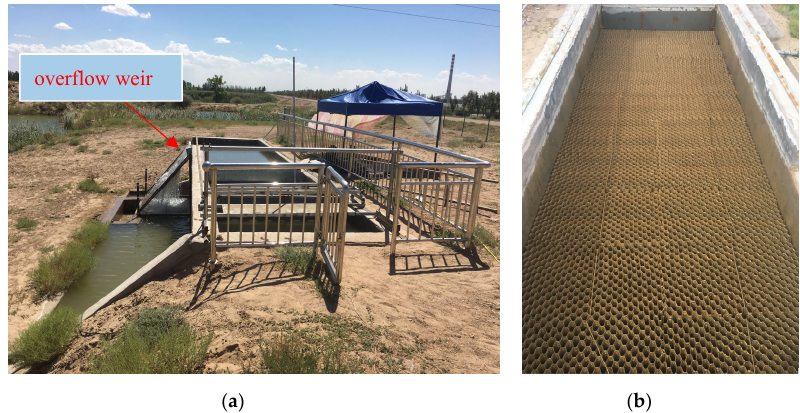
Figure 2. Photographs of the inclined-tube gravity sedimentation tank: ( a ) full view of the inclined-tube gravity sedimentation tank, ( b ) detailed view of inclined tubes.